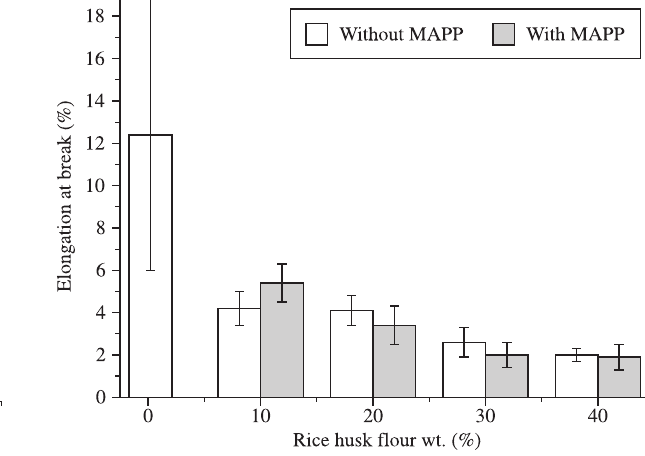
Figure 3. Effect of RHF and MAPP on elongation-at-break.